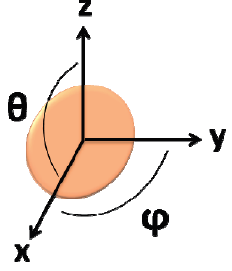
Figure 13. Axis and angles considered for Wolfram Mathematica 7.0